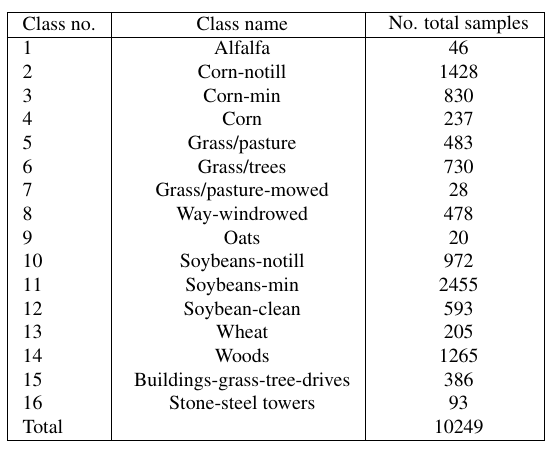
Table 1. Indian pines dataset: class numbers, class names, and number of observations for each class Class no.